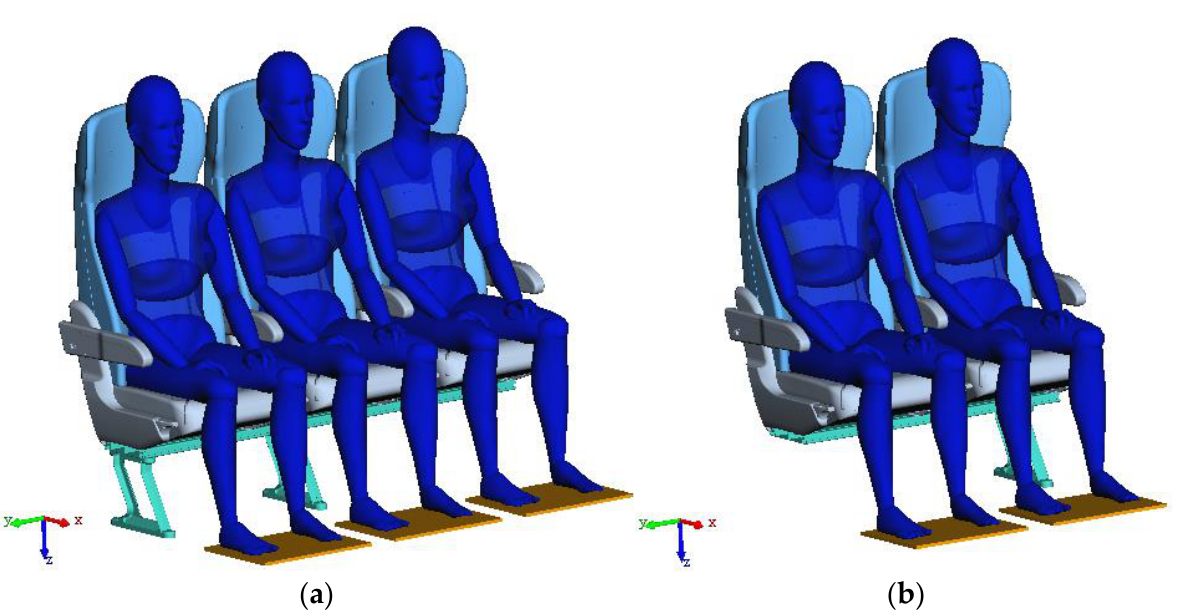
Figure 7. Seat – human body coupled dynamics model of high-speed trains. ( a ) Three-seat model; ( b ) two-seat model.